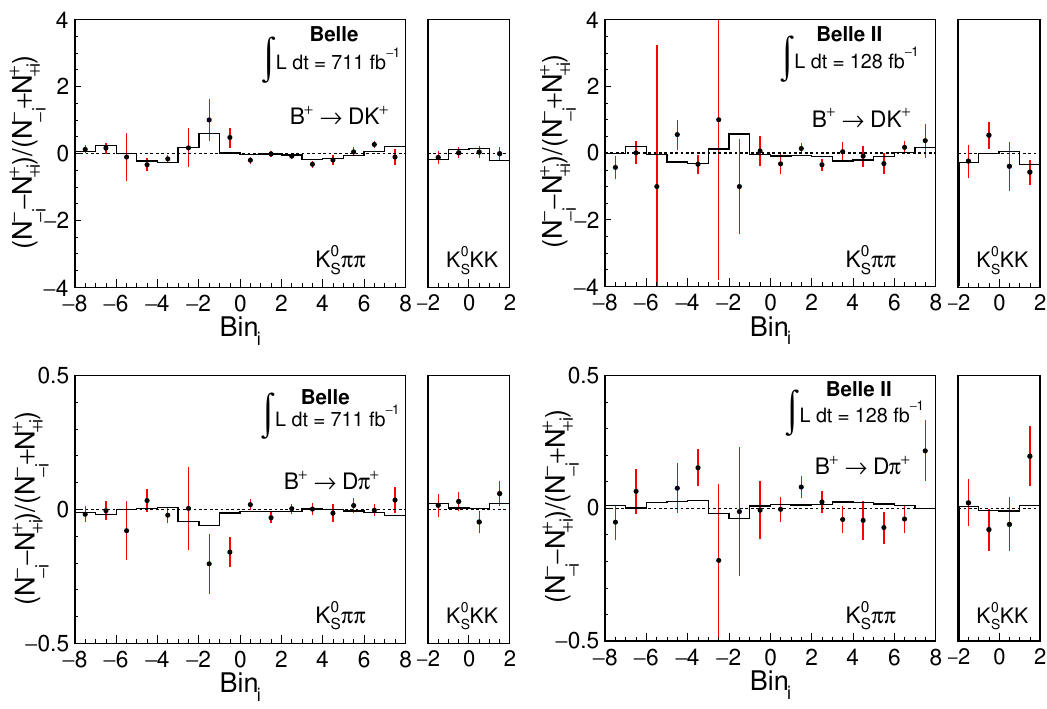
(cid:0) (cid:1) (cid:0) (cid:1) in each Dalitz plot bin + N + N − − N + / N − − i + i − i + i